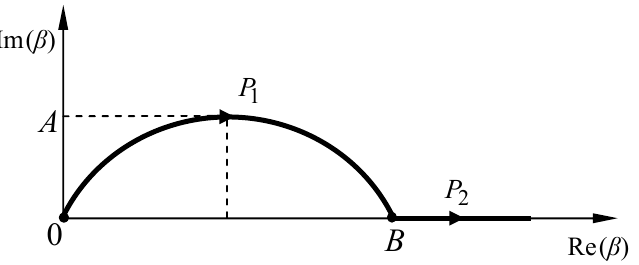
Figure 5. Parabolic deformed integration